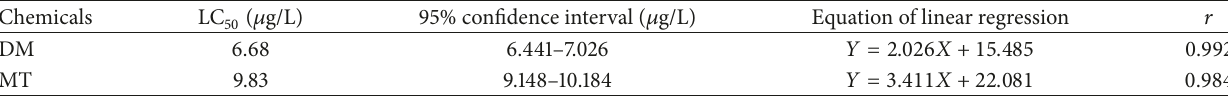
Table 1: The 24 h acute toxic effects of both DM and MT on D. magna